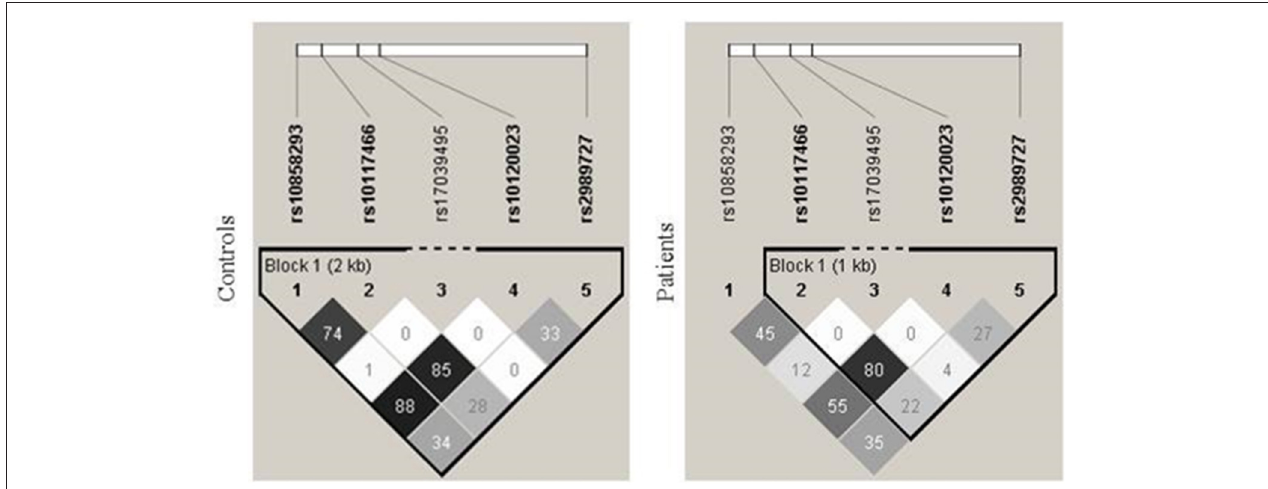
FIGURE 1 | Linkage disequilibrium between FCN1 single nucleotide polymorphisms. There was strong linkage disequilibrium (LD) between the SNPs rs10120023 ( − 542G > A) and rs10117466 ( − 144C > A), as indicated by the correlation coefficient values (r 2 ). An evidence of recombination was found between the SNP rs10858293 ( + 33T > G) in exon 1 and the promoter variants in patients.